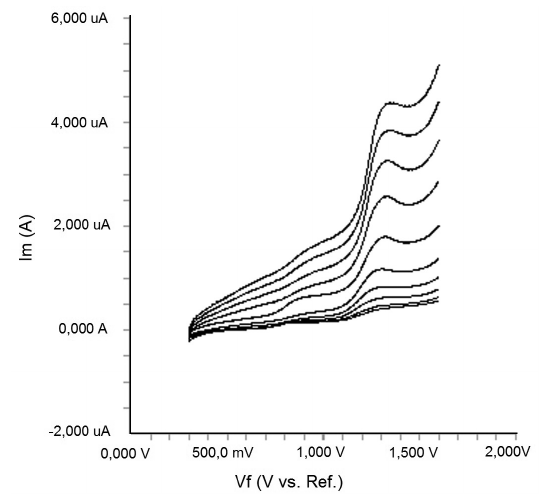
FIGURE 3 - Linear sweep voltammograms for the oxidation of 20 μg mL -1 diclofenac in acetonitrile containing 0.1 M TBAClO as a function of scan